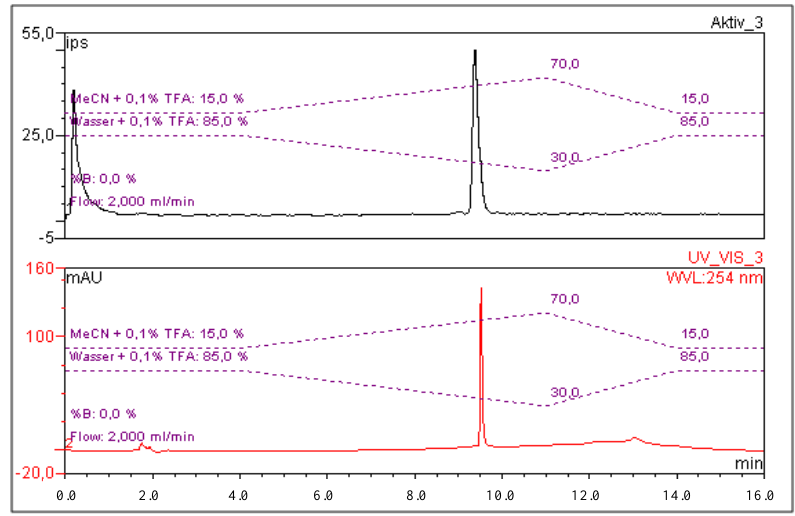
Figure 1. Exemplary chromatograms of [ 68 Ga]Ga-CHX-A''-DTPA-DUPA-Pep in the radioactivity channel (upper signal; the first peak shows the total activity injected detector bypass for recovery rate calculation) and CHX-A''-DTPA-DUPA-Pep in the UV-channel (bottom signal; λ: 254